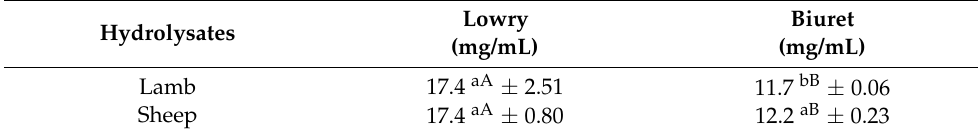
Table 1. Mean protein content found for hydrolysates of lamb and sheep collagen.